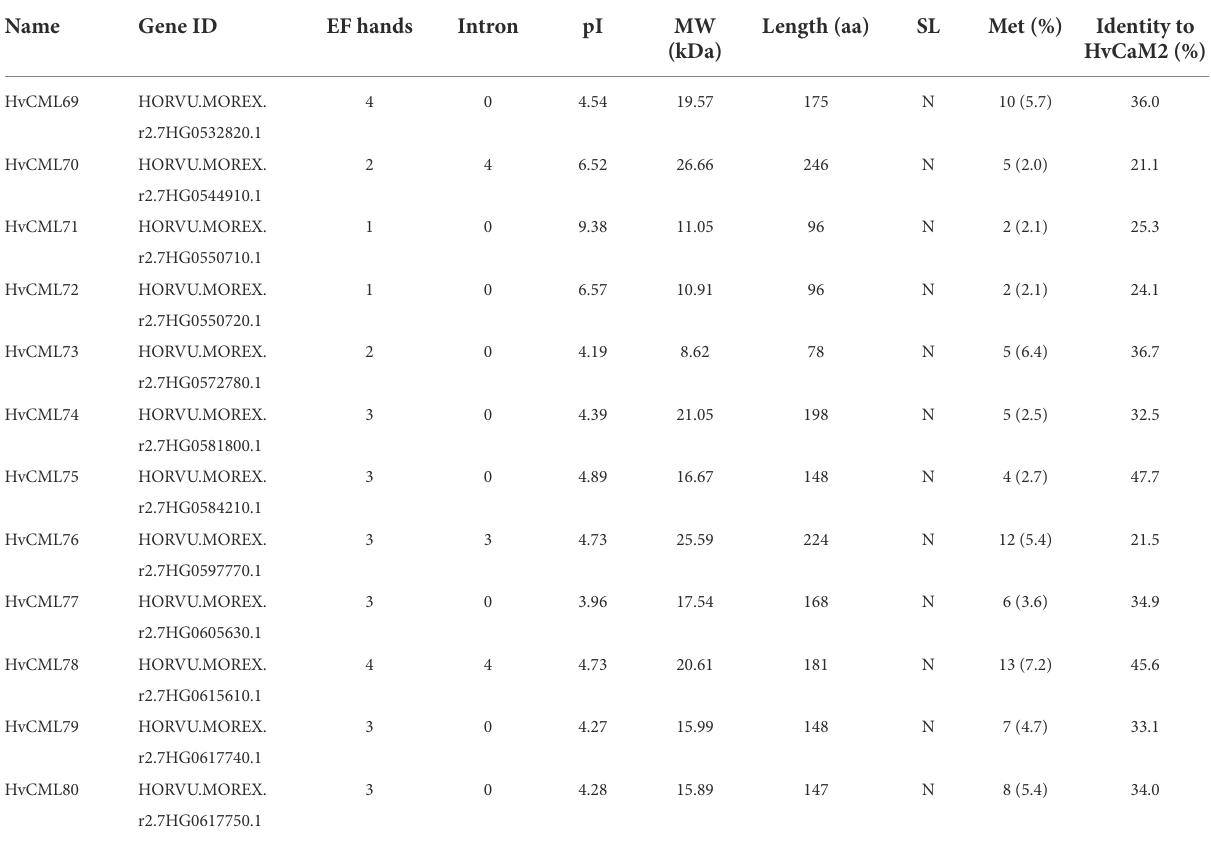
The 2 kb upstream sequences of HvCaMs/CMLs coding regions were retrieved for cis -acting elements analysis. Totally, could be fractionalized into 6 types based on functional annotations (Figure 4; Supplementary File 4). Nearly half of the cis -acting elements (31, 44.9%) were in ‘light responsiveness’ category, followed by ones in ‘hormone response’ (11, 15.9%), ‘promoter/ enhancer element’ (11, 15.9%), ‘development/tissue specificity’ (8, 11.6%) and ‘stress’ category (7, 10.1%). Only one kind of elements was identified in ‘circadian control’ category (Figure 4). CAAT-box and TATA-box in ‘promoter/enhancer element’ category, which are binding sites of RNA polymerase and responsible for transcription efficiency, were ubiquitously detected in all HvCaMs/CMLs , indicating their potential critical roles in controlling the transcription initiation and